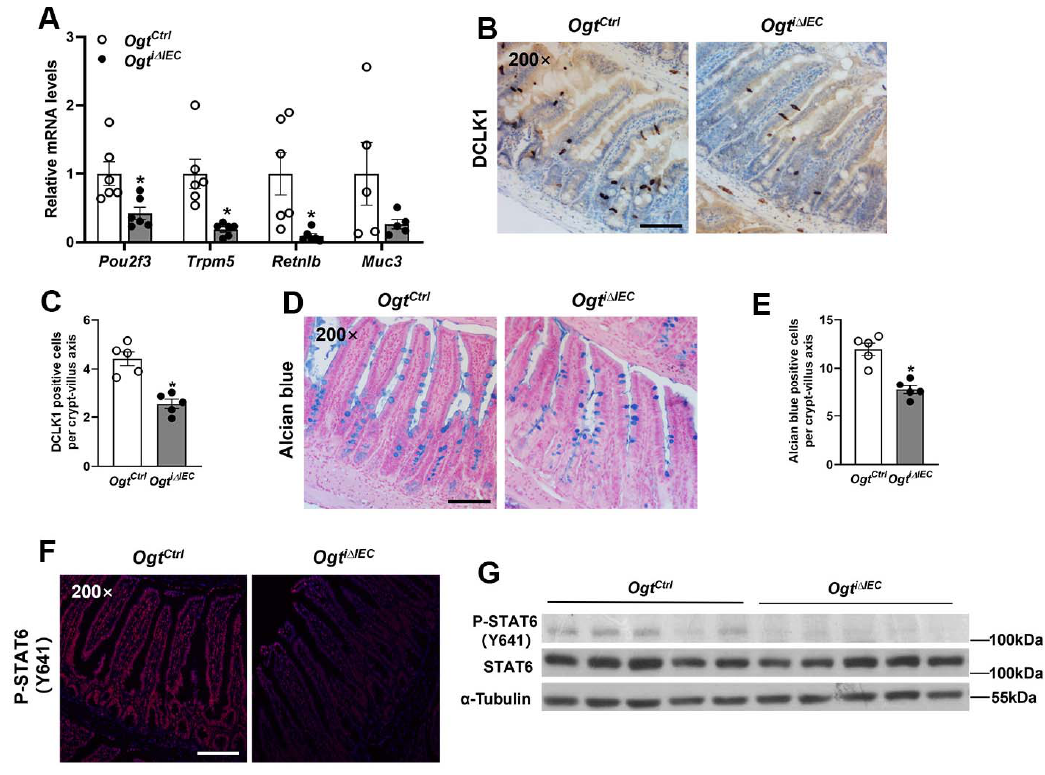
Figure 3. Epithelial OGT is required for tuft and goblet cell differentiation in adult mice. The 8–10-week-old Ogt Ctrl and Ogt i ∆ IEC male mice were subjected to the following analyses. ( A ) qPCR analysis of tuft ( Pou2f3 , Trpm5 ) and goblet ( Retnlb , Muc3 ) cell markers expression ( n = 5–6/group). ( B ) Jejunal tuft cells were examined by DCLK1 IHC staining. ( C ) Quantification of tuft (DCLK1 posi- tive) cells shown in ( B ) ( n = 5/group, 20 crypt-villus units counted for each mouse). ( D ) Jejunal goblet cells were examined by Alcian blue staining. ( E ) Quantification of goblet (Alcian blue positive) cells shown in ( D ) ( n = 5/group, 20 crypt-villus units counted for each mouse). ( F ) Immunofluorescence for P-STAT6 (Y641) in the jejunum. ( G ) Western blot analysis of P-STAT6 (Y641) expression in the jejunal IECs. Data are presented as mean ± SEM. * p < 0.05. Scale bars, 100 µ